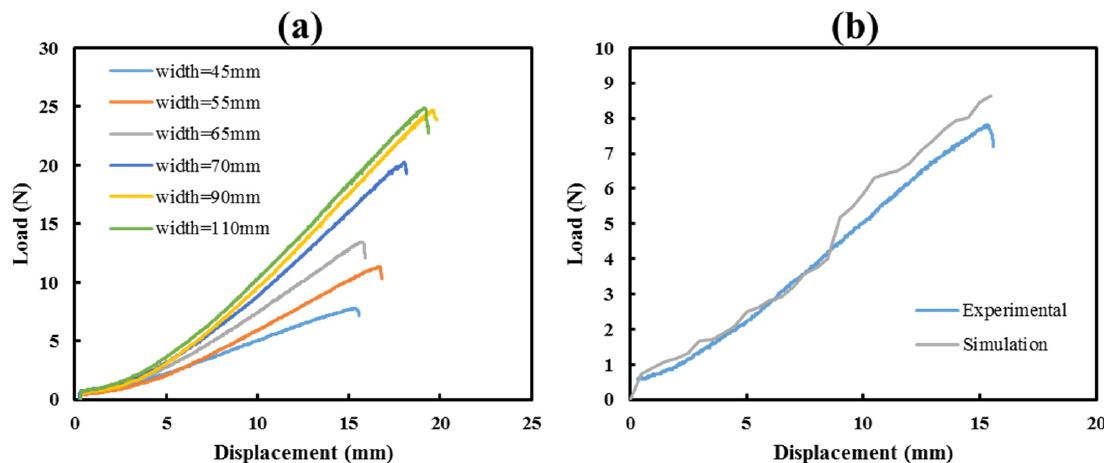
Figure 6. Force displacement curves: ( a ) experimental data for the Al sheet with 1 mm thickness at 20 mm/min punch velocity and ( b ) comparison of the experimental and numerical results for two samples at the same punch speed and thickness conditions.